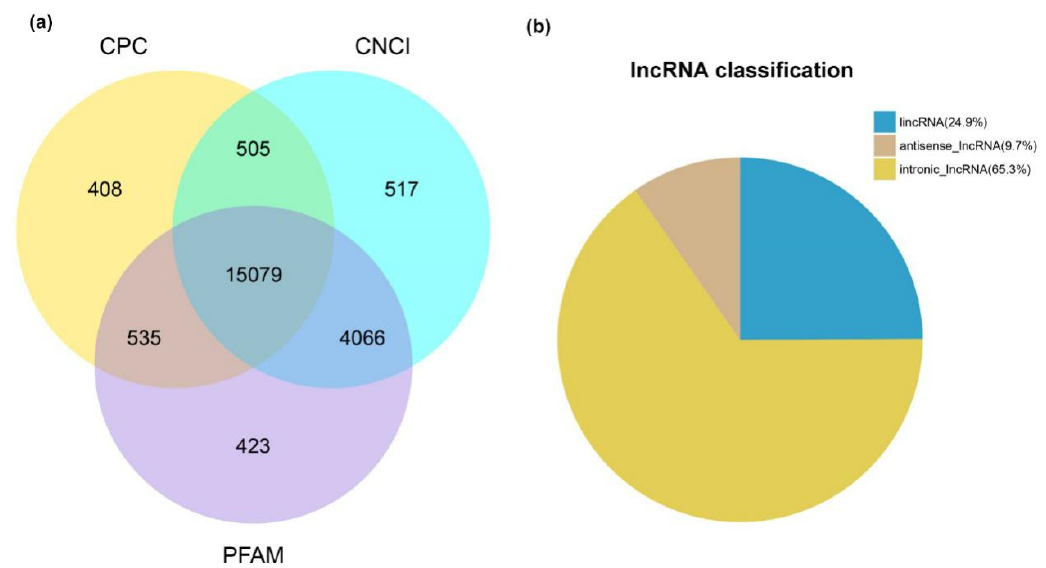
Figure 1. Identification of goat skeletal muscle long non-coding RNAs (lncRNAs). ( a ) Venn diagram presentation for prediction of coding potential using three software identifications, including CPC analysis, CNCI analysis, and Pfam protein domain analysis. ( b ) Pie chart of different types of lncRNAs. Blue: lincRNA; Khaki: antisense_lncRNA; Yellow: intronic_lncRNA.